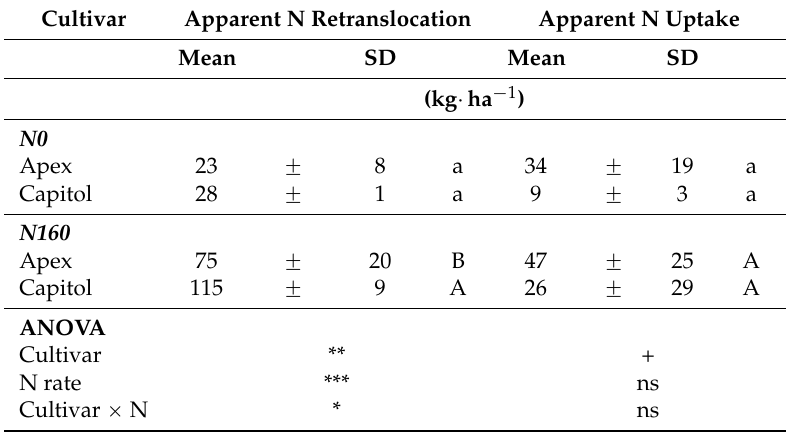
Table 1. Apparent N retranslocation and apparent N uptake directly allocated to the pods from full flowering to maturity of the winter oilseed-rape line-cultivars Apex and Capitol as affected by the N fertilization rate (N0 and N160). ANOVA: +, *, **, and *** indicate significant differences at p < 0.10, p < 0.05, p < 0.01, and p < 0.001, respectively. ns = non-significant. Different lower case and upper case letters indicate significant cultivar differences within the cultivars at N0 and N160, respectively, at p < 0.05. SD = Standard deviations of the means ( n =